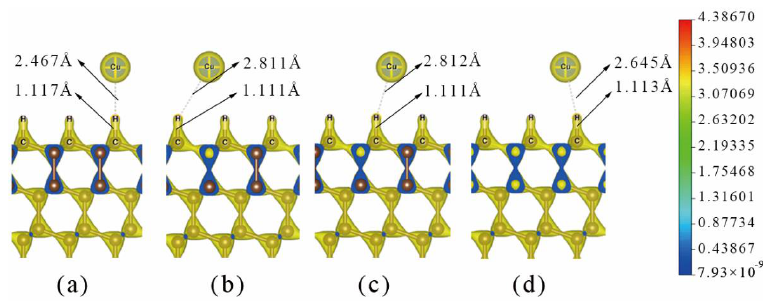
Figure 5. ( a – d ) Charge density maps of a single Cu atom adsorbed on the Top, T4, H3, and Br ad- sorption sites, respectively. adsorption sites,